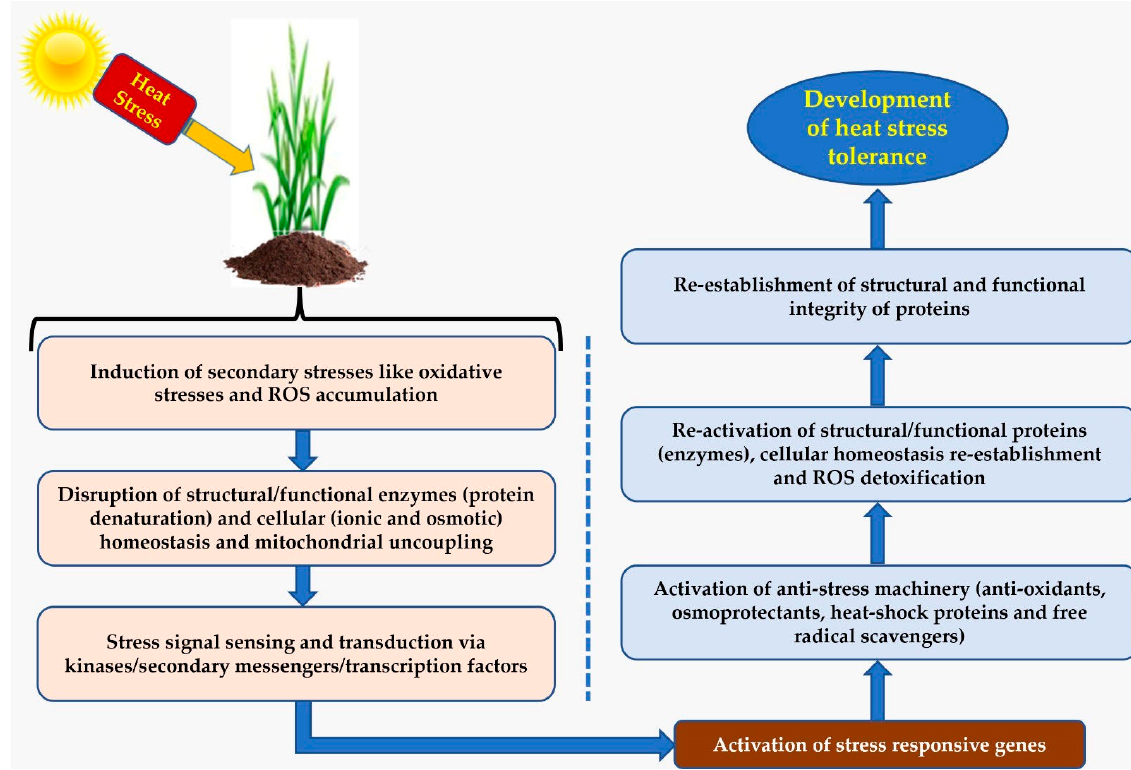
Figure 2. Development of heat tolerance responses and mechanism under HS in wheat.